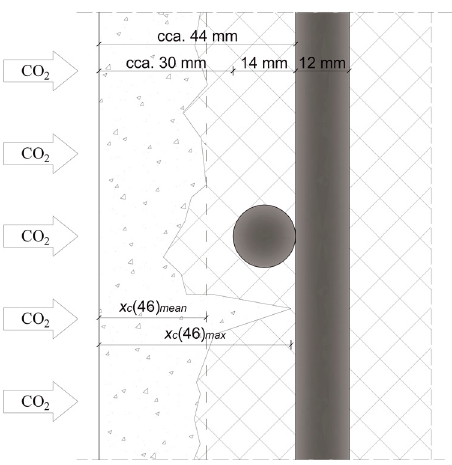
Figure 5. Properties of measured carbonation depths and reinforcement in bridge wings, obtained from the design documents and the performed tests.